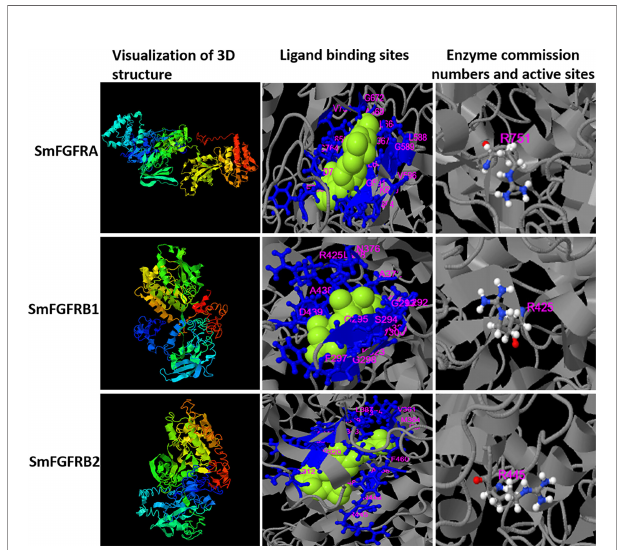
FIGURE 1 | Three-dimensional (3D) structure (column 1), the predicted binding ligands (green spheres) and binding residues (blue balls and sticks) (column 2), and enzyme active sites (colored balls and sticks) (column 3) for S. mansoni FGFRA (Con fi dence score=-2.22), FGFRB1 (Con fi dence score=-2.7) and FGFRB2 (Con fi dence score=-3.74) predicted by the I-TASSER server. The residue numbers are shown in pink.